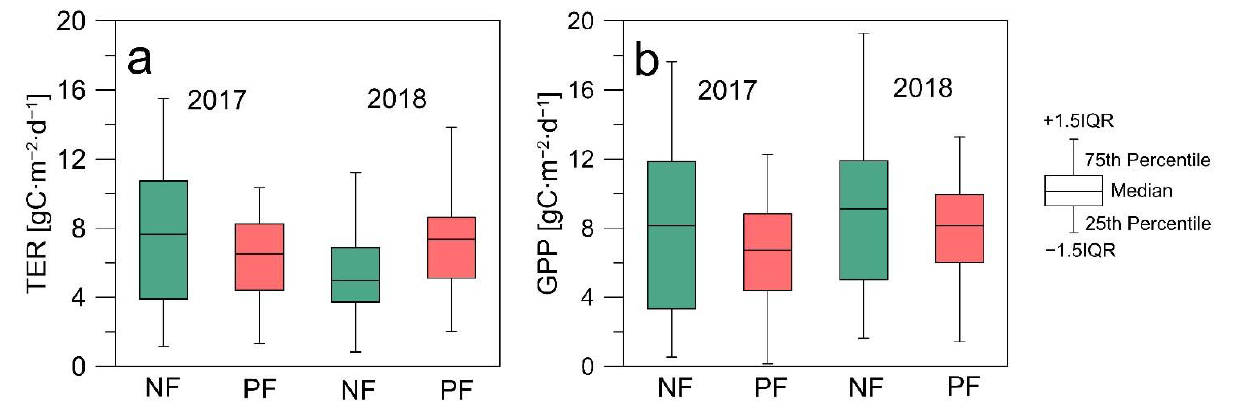
Figure 8. Boxplots of the mean daily ( a ) total ecosystem respiration (TER) and ( b ) gross primary production (GPP) in the growing seasons (12 April − 11 October) of 2017 and 2018 in the nemorose spruce forest (NF, this study) and the paludified spruce forest (PF) [51].